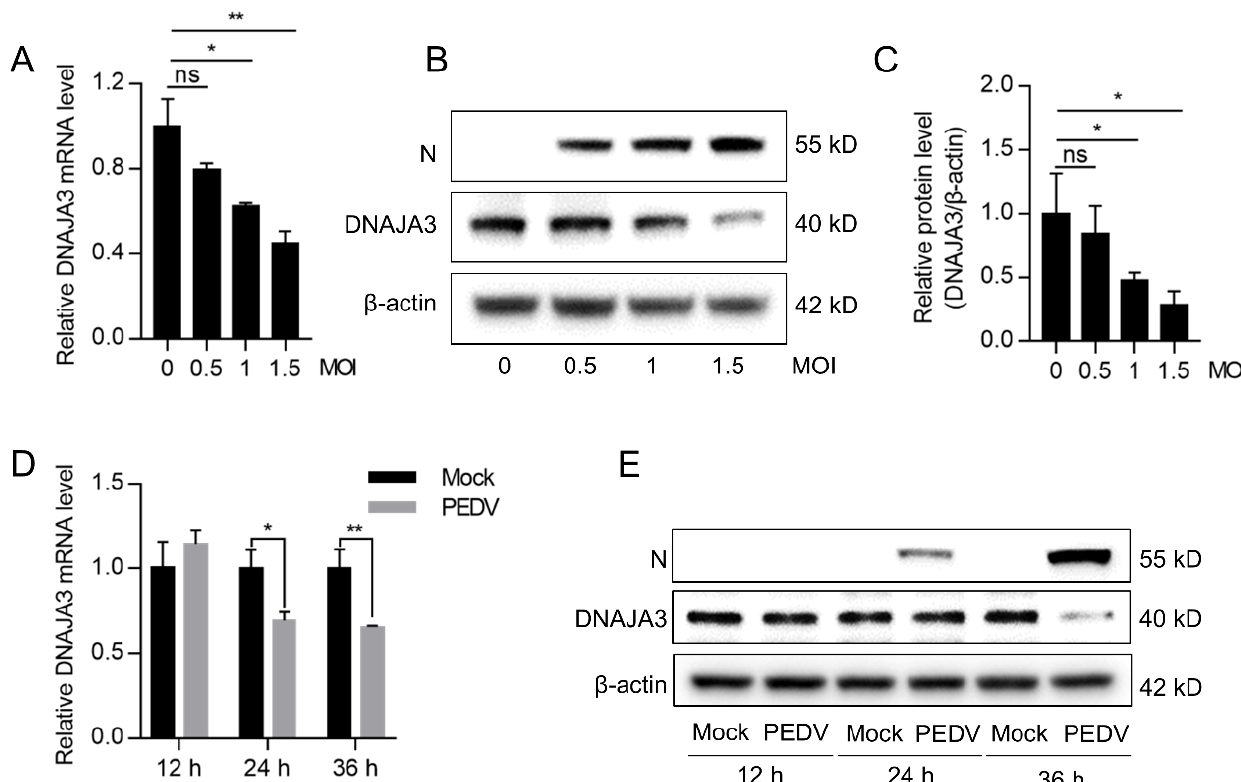
Figure 3. PEDV infection downregulated DNAJA3 expression in a dose and time-dependent manner. IPEC-J2 cells were infected with different MOI of PEDV. ( A , B ): At 24 h, relative mRNA level ( A ) and protein level ( B ) of DNAJA3 were detected by qPCR and Western blotting. ( C ): Ratio of DNAJA3 to β -actin of panel B by densitometric analysis. D&E: IPEC-J2 cells were infected with PEDV (0.5 MOI), and the mRNA level ( D ) and protein level ( E ) of DNAJA3 at 12, 24 and 36 h. All results are presented as the mean ± SD of data from three independent experiments. *, p < 0.05; **, p < 0.01.